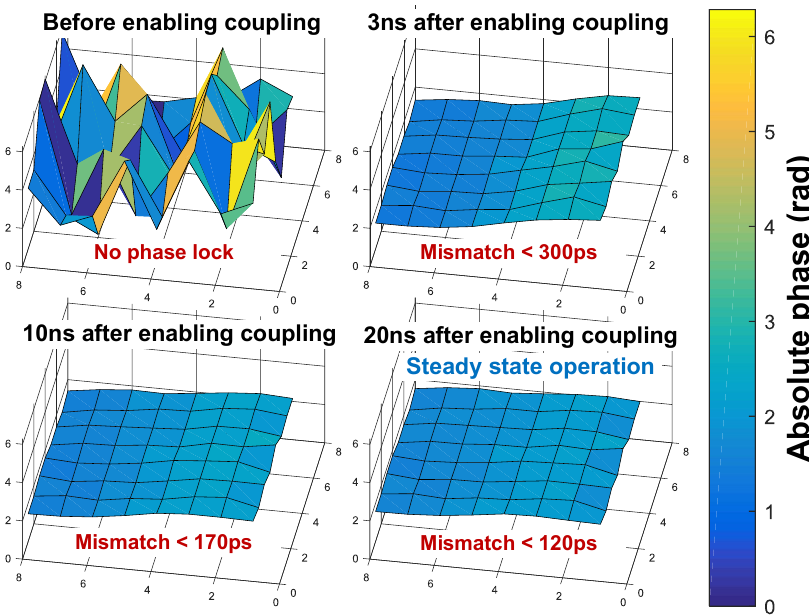
Figure 13. Instantaneous phase mismatch progression, for ± 10% RO period variation over the implemented 8 × 8 TDCs.